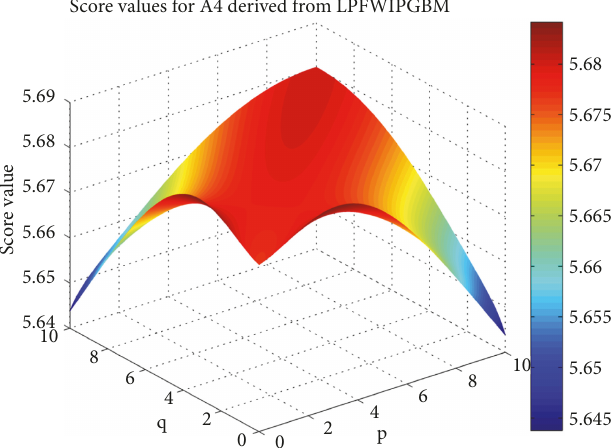
Score values for A4 derived from LPFWIPGBM